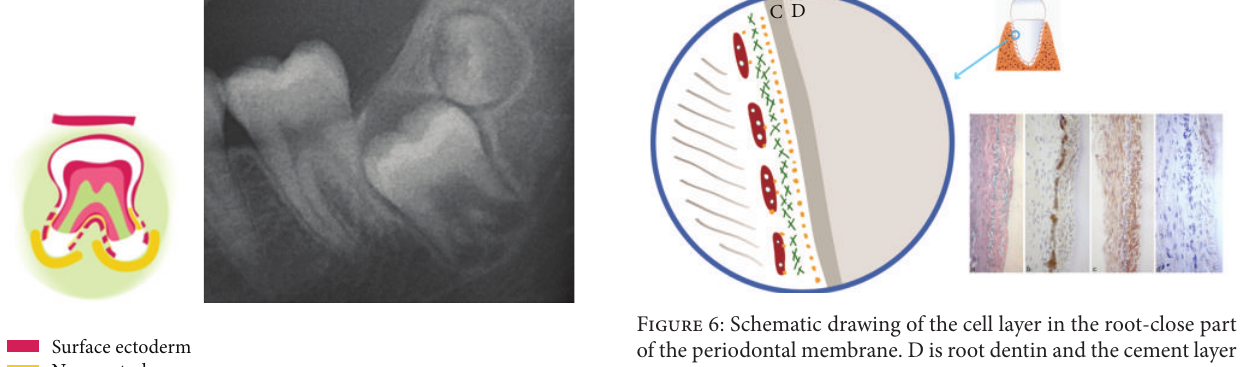
Surface ectoderm Neuroectoderm Figure 5: Schematic drawing and radiograph showing themorphol- ogy of a mandibular first molar shortly before eruption. Note the ectodermal cell layer of the follicle surrounding the crown and the strong innervation in the root sheet.